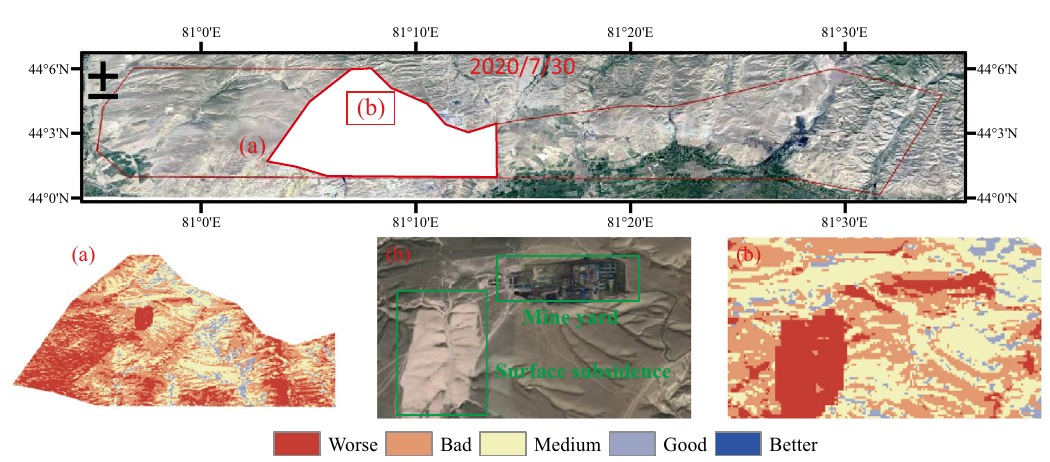
Figure 13. High mining intensity area ( a ), surface subsidence area ( b ) and corresponding eco-environmental quality characteristics. The Figure is created using Google Earth Pro ver.7.3.4 (http:// www. googl ediqiu.